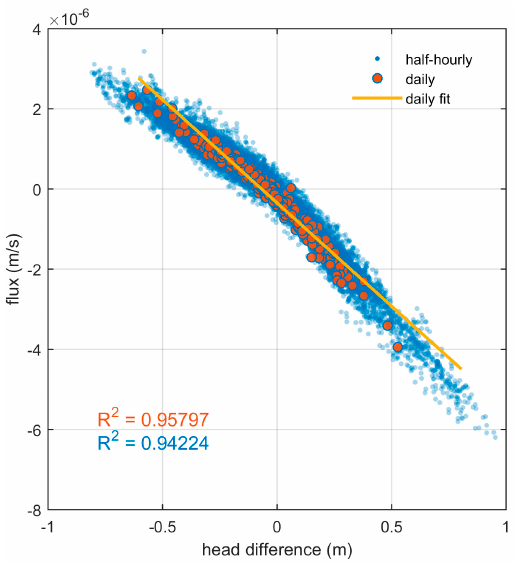
Figure 4. Vertical fluxes versus the head difference between the river stage and inland water table level at Spring 9 at daily and half-hourly scales.